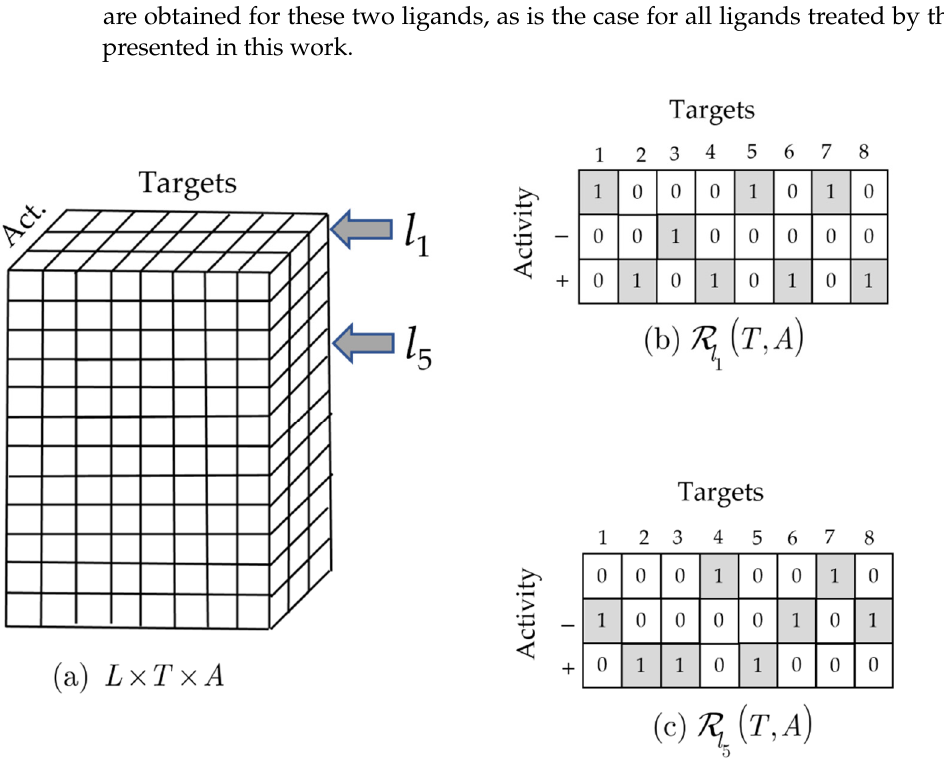
Figure 4. ( a ) Ternary reference set. ( b ) Ligand-based subrelation associated with 𝑙 (cid:2869) , ℛ (cid:3039) {𝑙 } × 𝑇 × 𝐴 . ( c ) Ligand-based subrelation associated with l 5 , R l